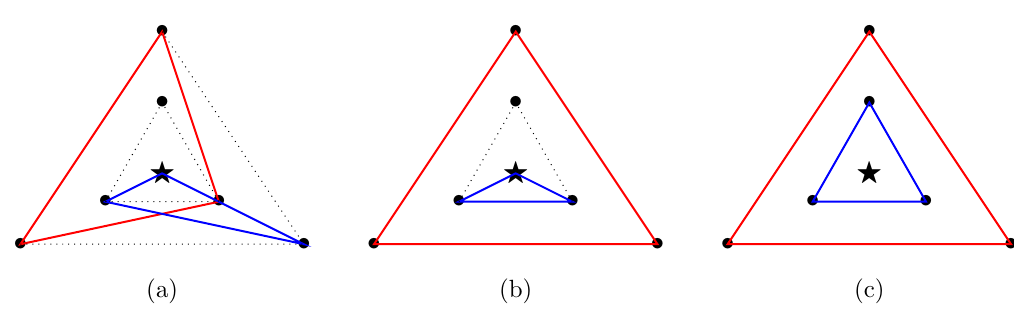
Figure 11. Three two triangle con(cid:12)gurations which are equivalent by continuous deformations among each